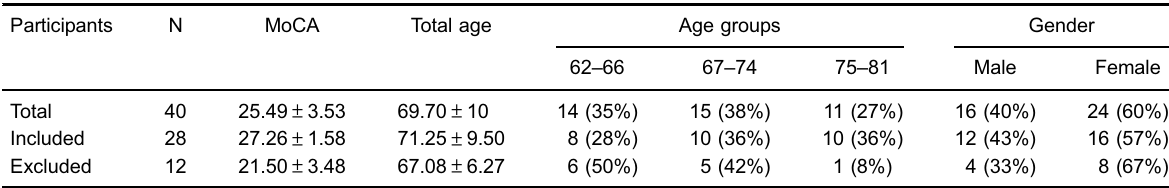
Table 1 . Descriptive characteristics of the